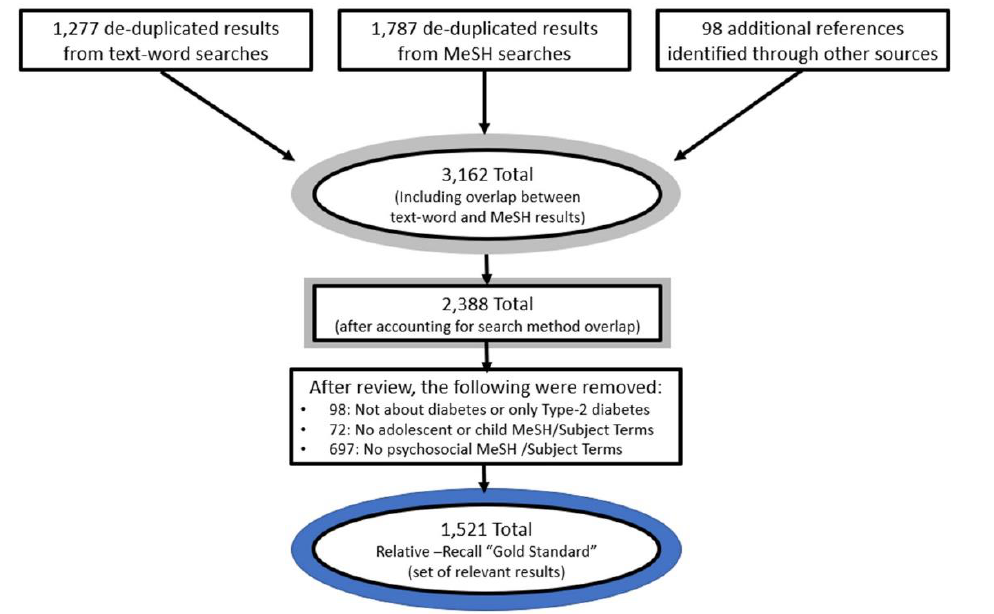
Figure 1 Flowchart of evaluation process